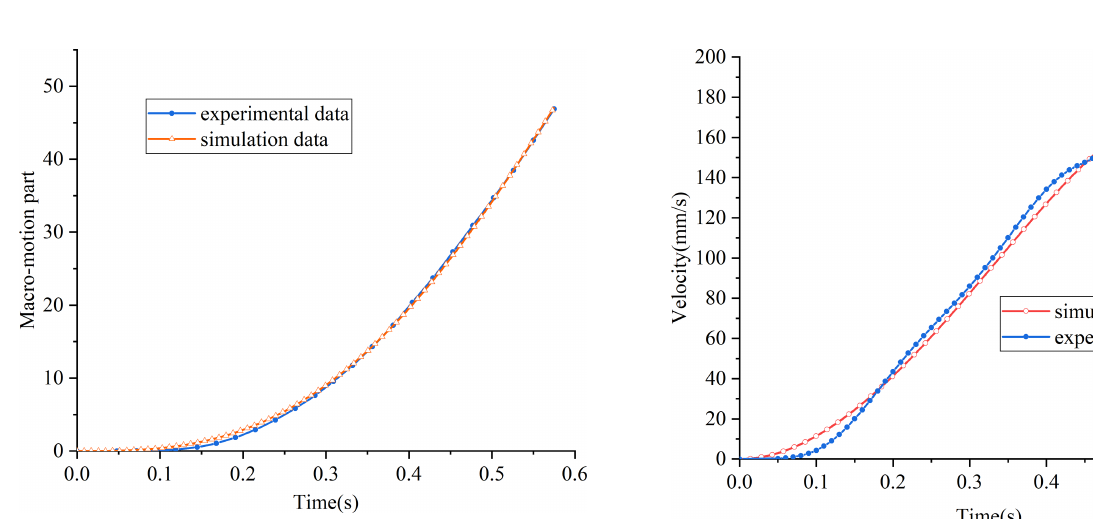
Figure 16. Block diagram of parameter identification model of macro-motion part.